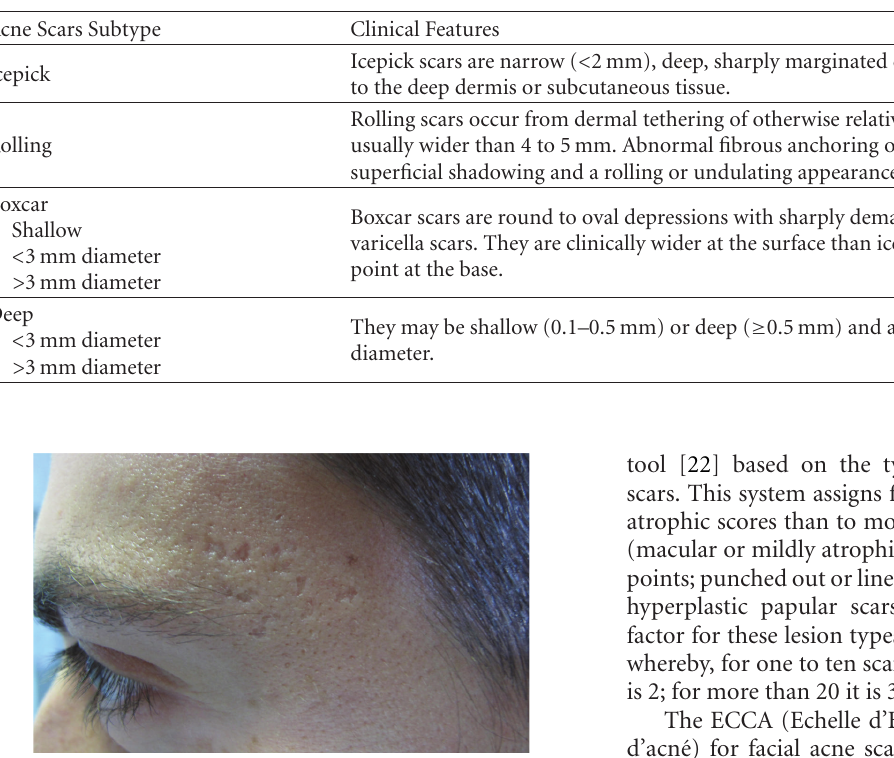
Table 1: Acne scar morphological classification (adapted from [20]).